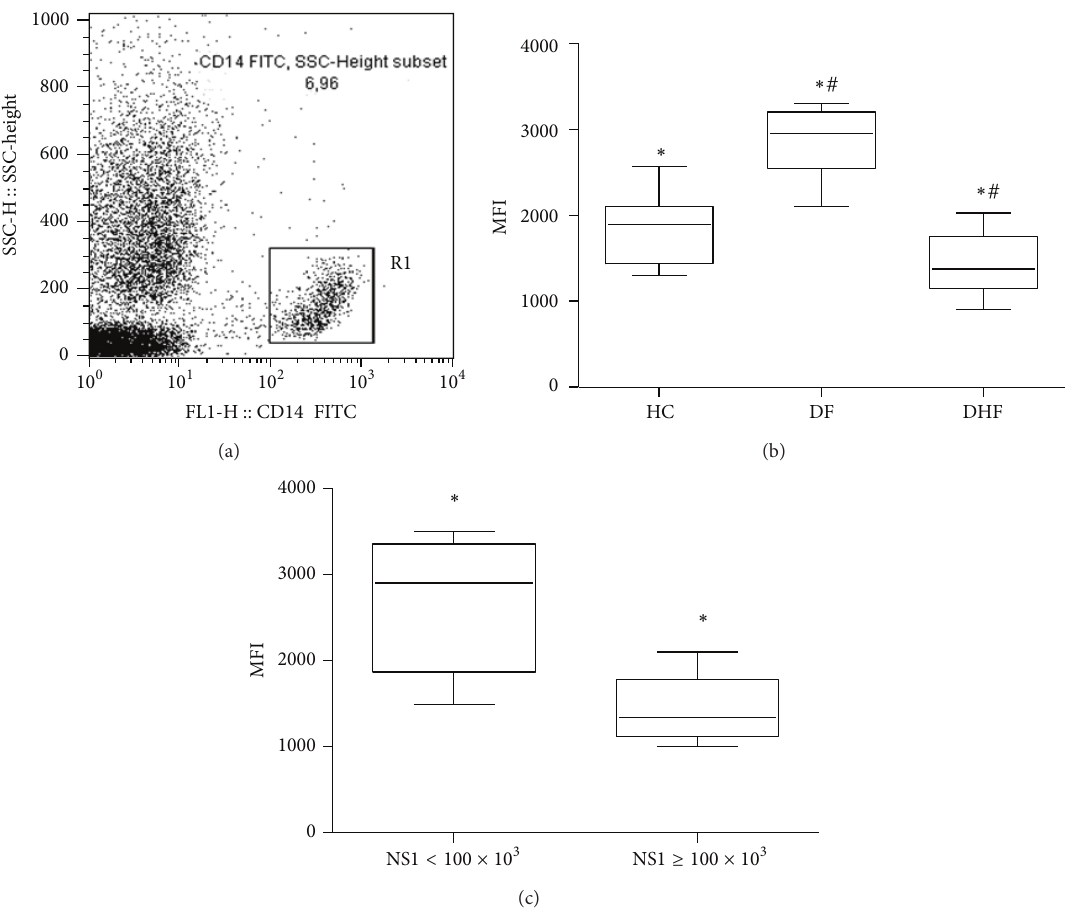
Figure 6: Toll-like receptor (TLR-4) expression of CD14 + cells from patients ( 𝑛 = 37 ) infected with dengue virus during the acute phase of the disease. (a) represents the gate strategy: a gate was drawn on SSC × FL1/CD14 + cells. (b) represents anti-TLR4-PE mean fluorescence intensity (MFI) of CD14 + cells from dengue fever (DF, 𝑛 = 26 ), dengue hemorrhagic fever (DHF, 𝑛 = 11 ), and healthy controls (HC, 𝑛 = 20 ). (c) represents anti-TLR4-PE MFI of CD14 + cells from dengue infected patients with low (NS1 < 100 × 10 3 BRU/mL) and high (NS1 ≥ 100 × 10 3 BRU/mL) dengue virus nonstructural protein 1 (NS1) serum levels. Results on (b) and (c) graphs were expressed as median using a box plot. Equivalent symbols ( ∗ , #) represent statistically significant differences ( 𝑃 < 0.05 ) between